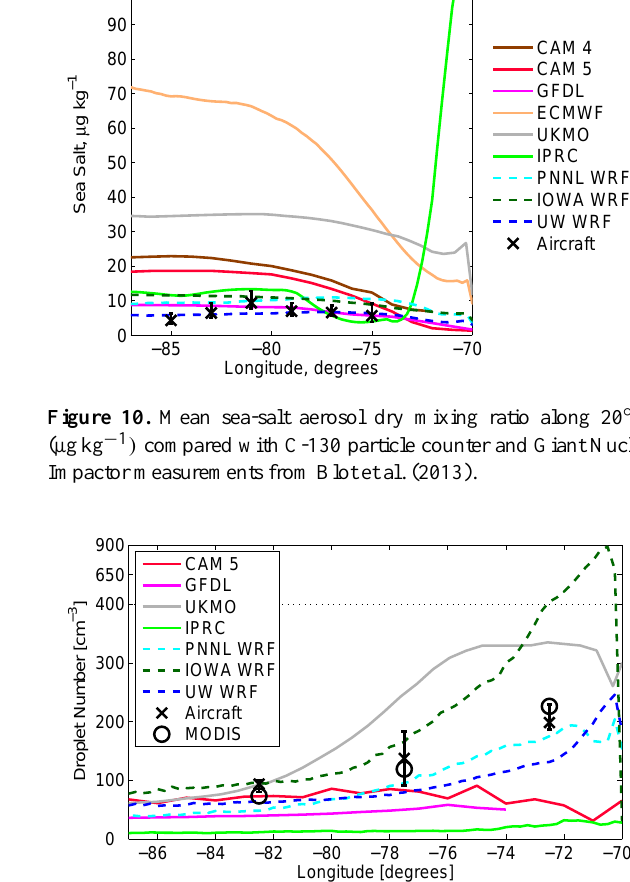
Figure 11. Mean cloud droplet number concentration, N d (in cm − 3 ), along 20 ◦ S compared with mean C-130 measurements us- ing a PMS cloud droplet probe and FSSP (forward scattering spec- trometer probe) as well as with MODIS estimates. This figure is modified from Mechoso et al. (2014) to add aircraft sampling vari- ability and MODIS data. The top section of the plot is